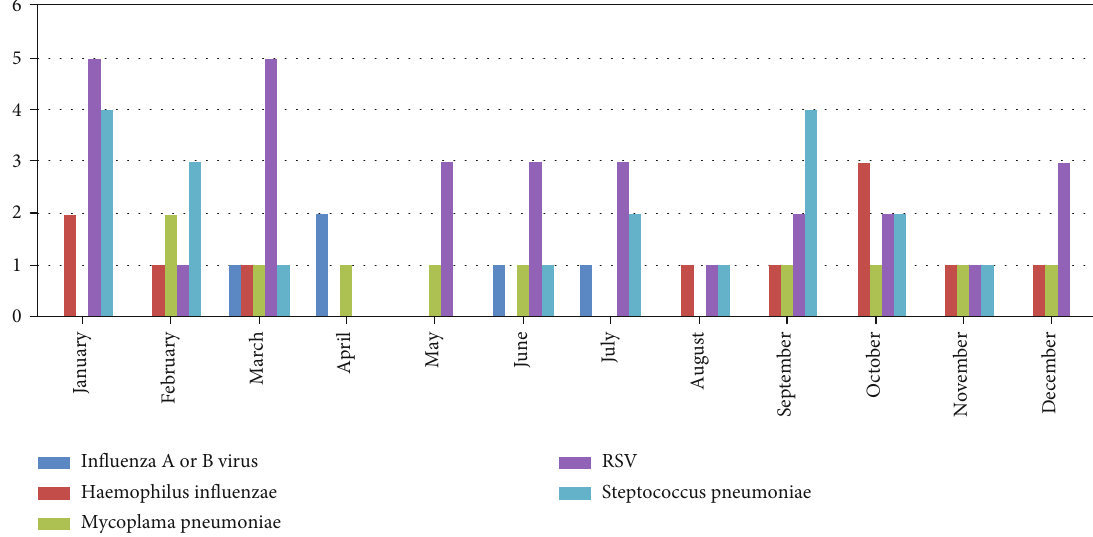
Figure 6: Distribution of microorganisms according to the seasonality.